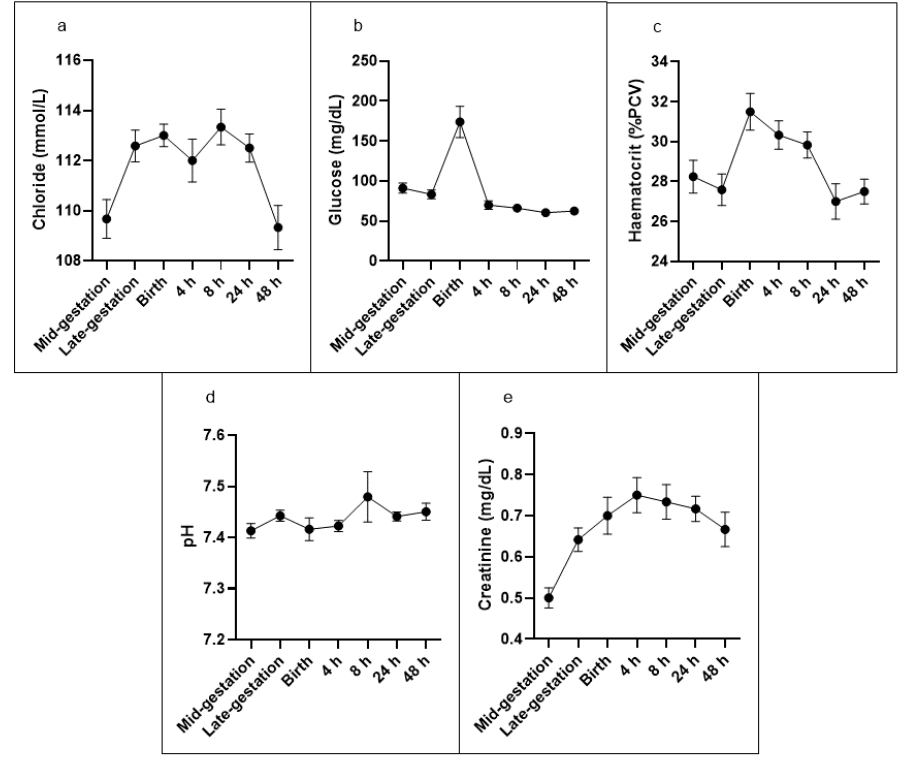
Figure 1. Average values (s.d. error bars) of 6 single bearing ewes at two time points before birth and five time points after birth for selected blood markers; ( a ) Average chloride (mmol/L), ( b ) Average glucose (mg/dL), ( c ) Average haematocrit (%PCV), ( d ) Average pH, ( e ) Average creatinine